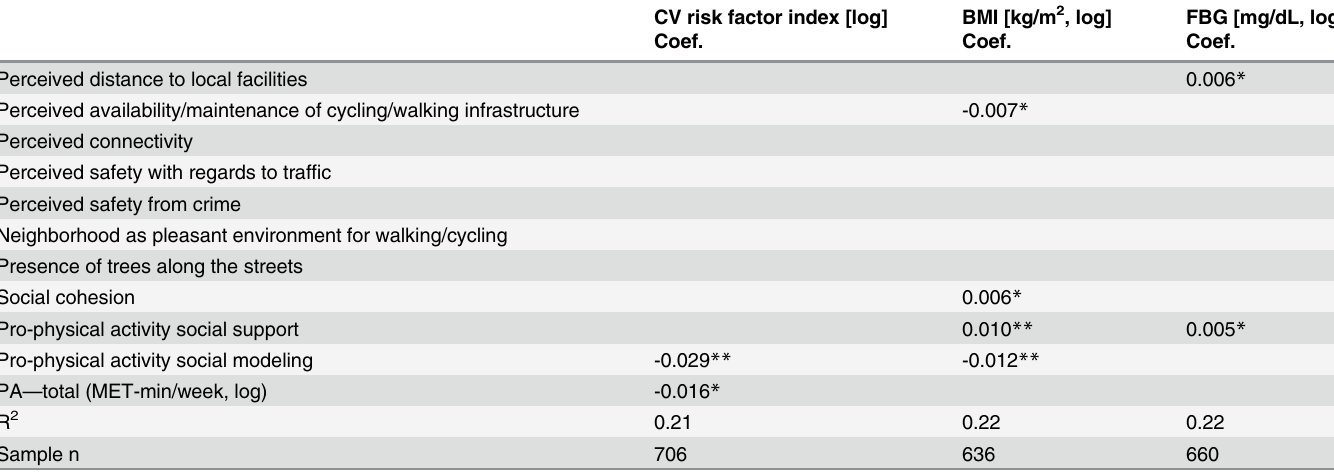
Table 5. Cardiovascular risk factors/behaviors by built and social residential characteristics as well as individual characteristics — final stepwise multiple linear regression model results (2) a